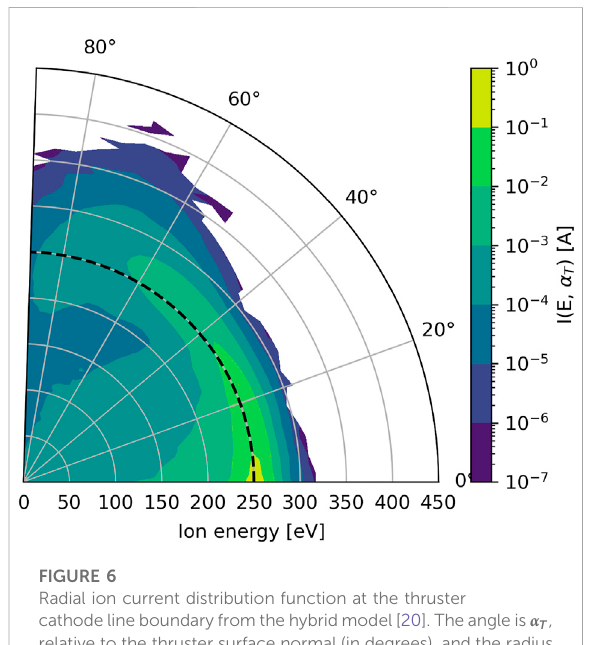
FIGURE 6 Radial ion current distribution function at the thruster cathode lineboundaryfromthehybridmodel[20].Theangle is α T , relative to the thruster surface normal (in degrees), and the radius represents the energy (in